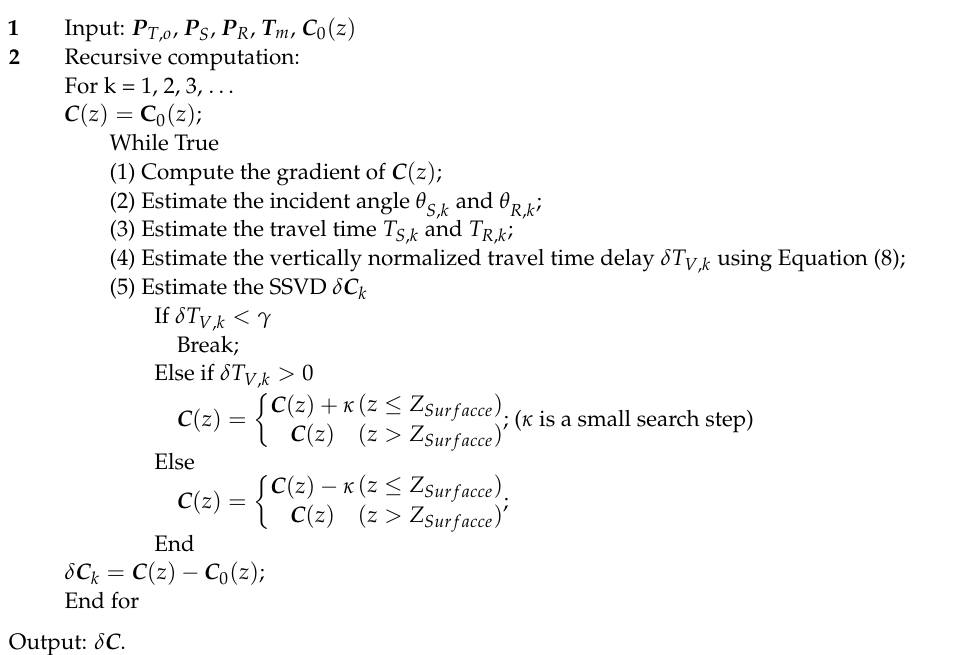
Algorithm 1 Surface sound velocity variation extraction